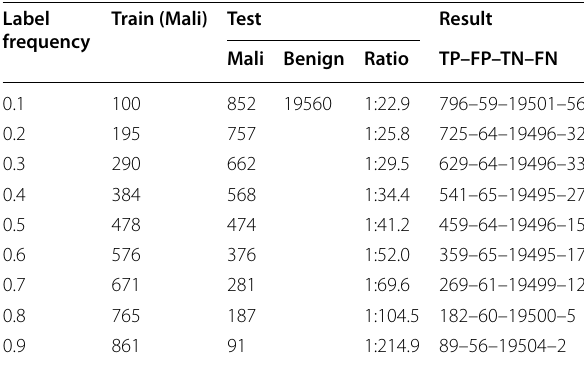
Table 8 Test data summerize Label Train (Mali) Test Result frequency